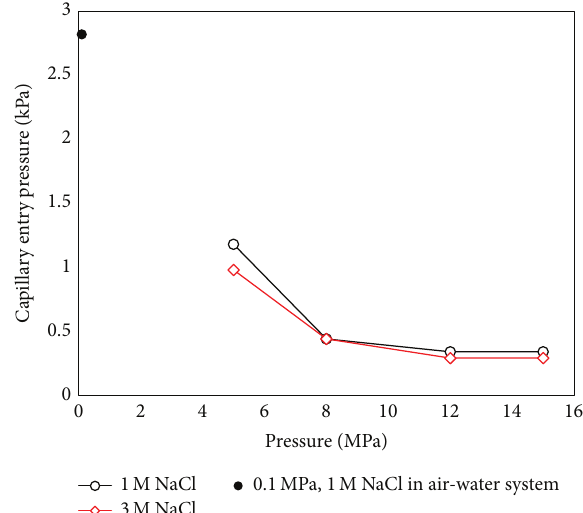
Figure 5: Capillary air (or CO 2 ) entry pressure changes depending on increased pressure. Black filled circle represents 0.1MPa, 1M NaCl using air-water system. Empty circle and diamond represent 1M and 3M NaCl using CO 2 -water system,